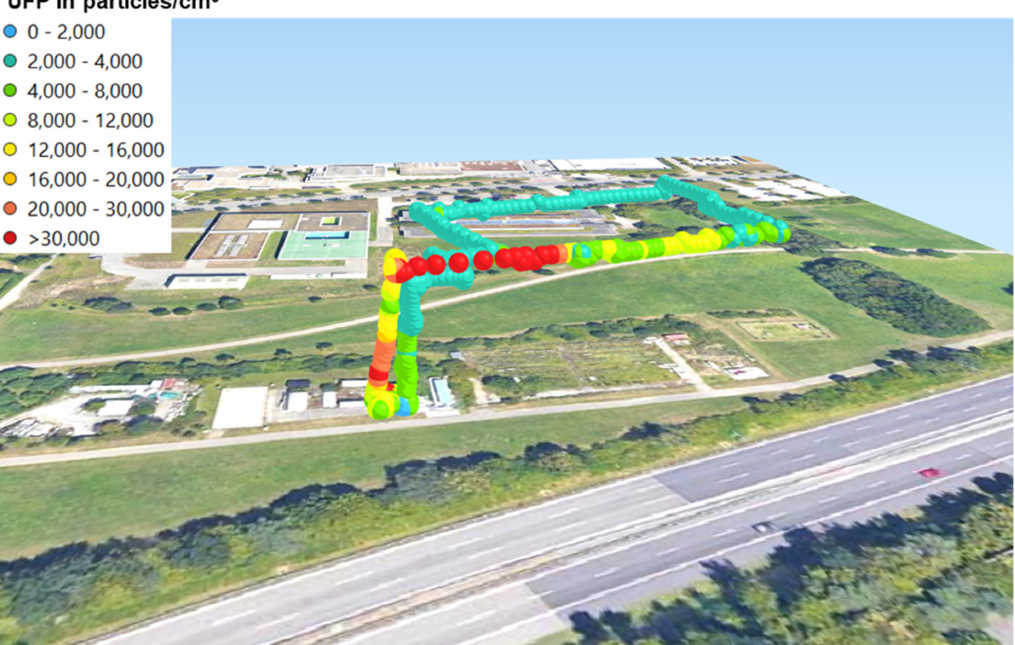
Figure 14. Three-dimensional visualization of the UFP concentrations measured with the DISCmini during the horizontal flight at 30 m AGL performed at 13:41 local time on 23 January 2021.